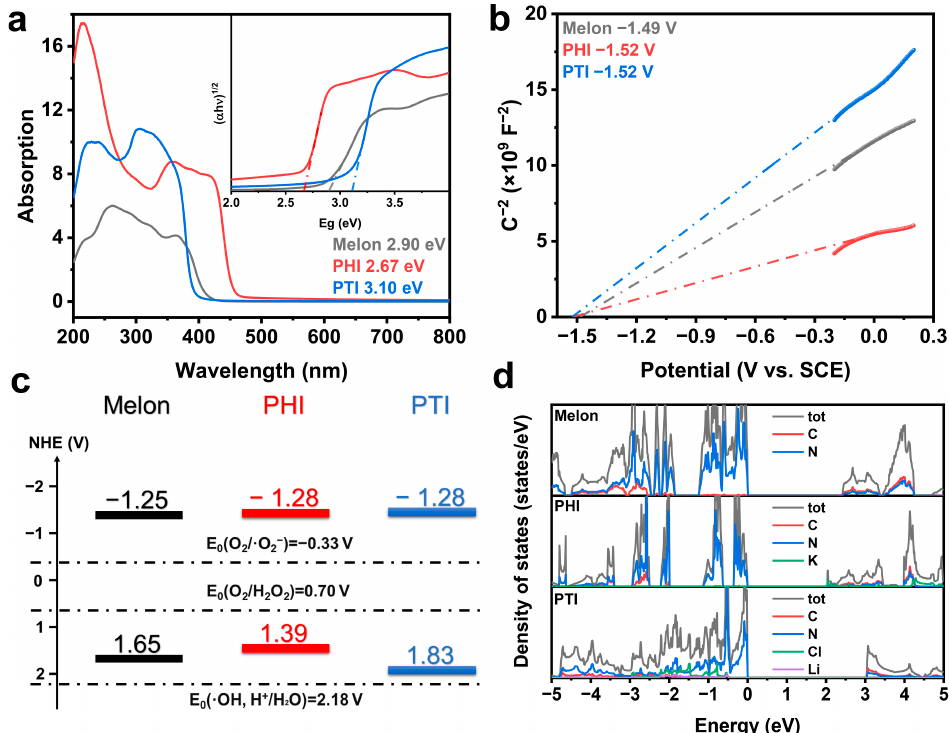
Figure 5. Electronic properties of g-C 3 N 4 . ( a ): UV-vis diffuse reflectance spectra, and the inset is the corresponding bandgaps. ( b ): Mott-Schottky plots. ( c ): Band structure alignments. ( d ): Electron density of states calculated by density functional theory.